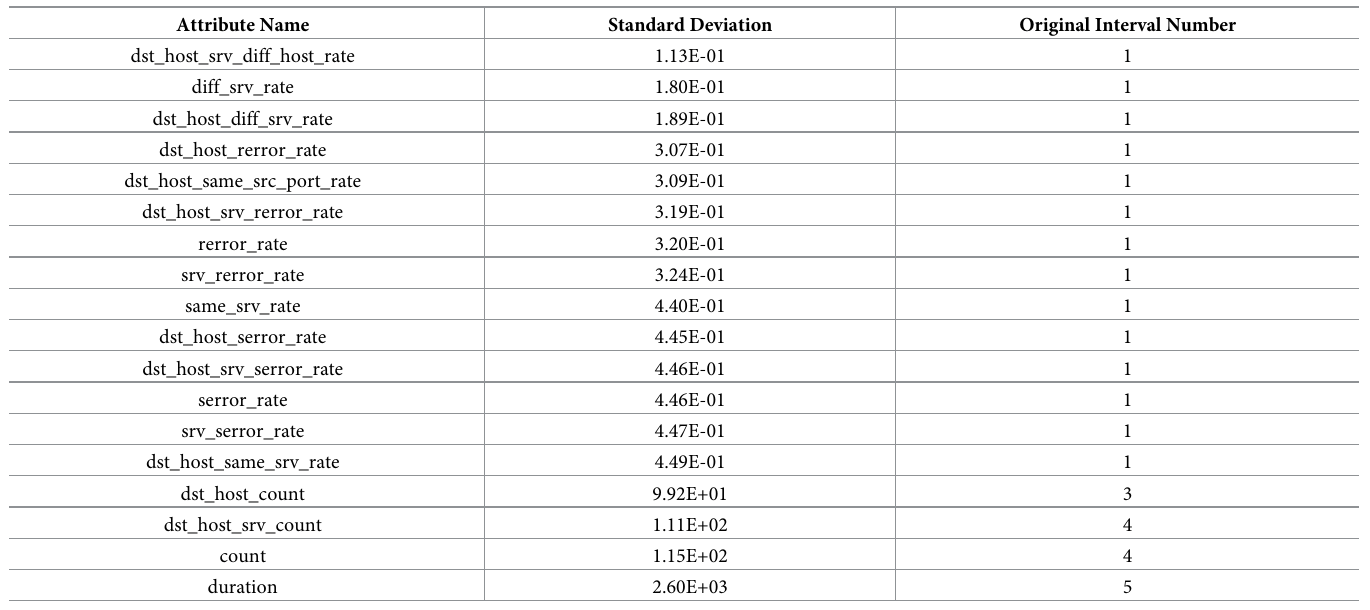
Table 3. The standard deviation and original interval number of attributes.